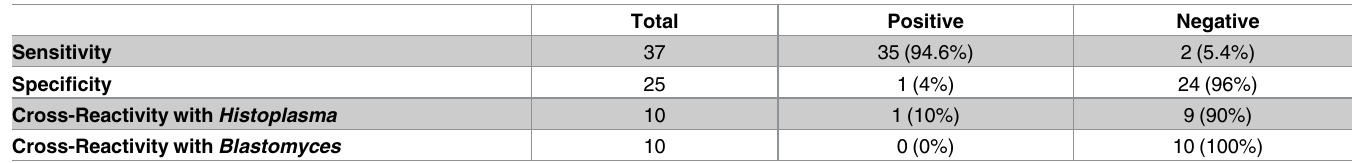
Table 3. Sensitivity and specificity of EIA in dogs. Sensitivity 37